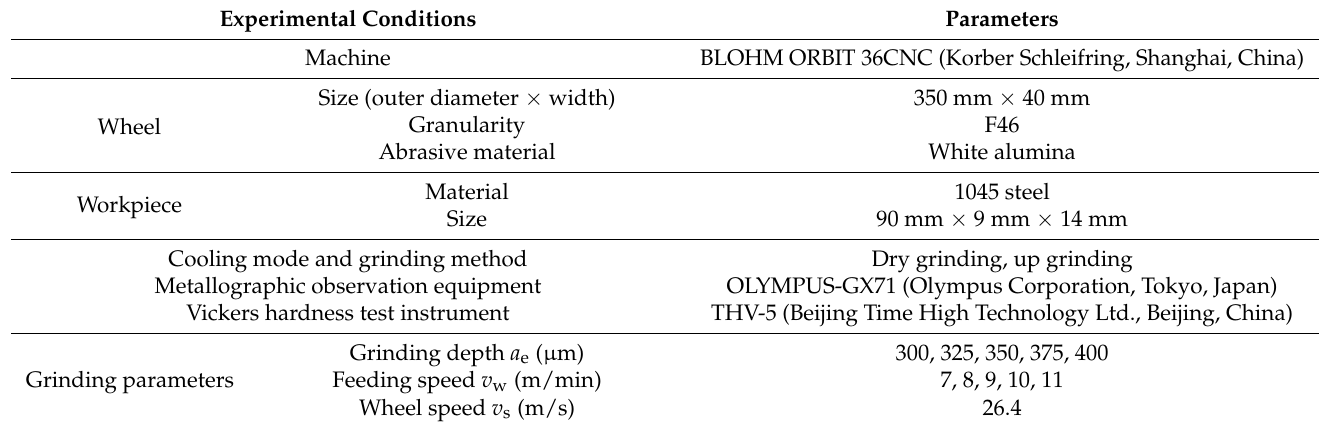
Table 3. The experimental conditions.